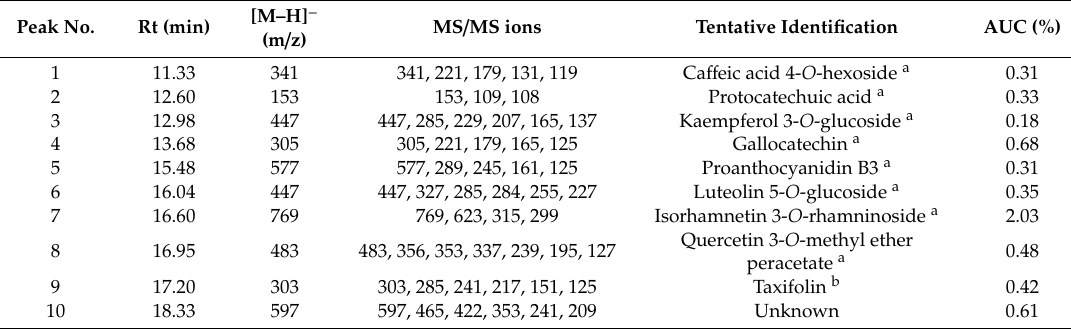
Figure 2. The HPLC-UV chromatogram profile of SPRE of R. prinoides (Kenya) at 360 nm. The peak numbers in the figure correlate to those in Table 3 below. Table 3. The HPLC-ESI-MS / MS data of the detected polyphenol profile of SPRE of R. prinoides (Kenya). Peak